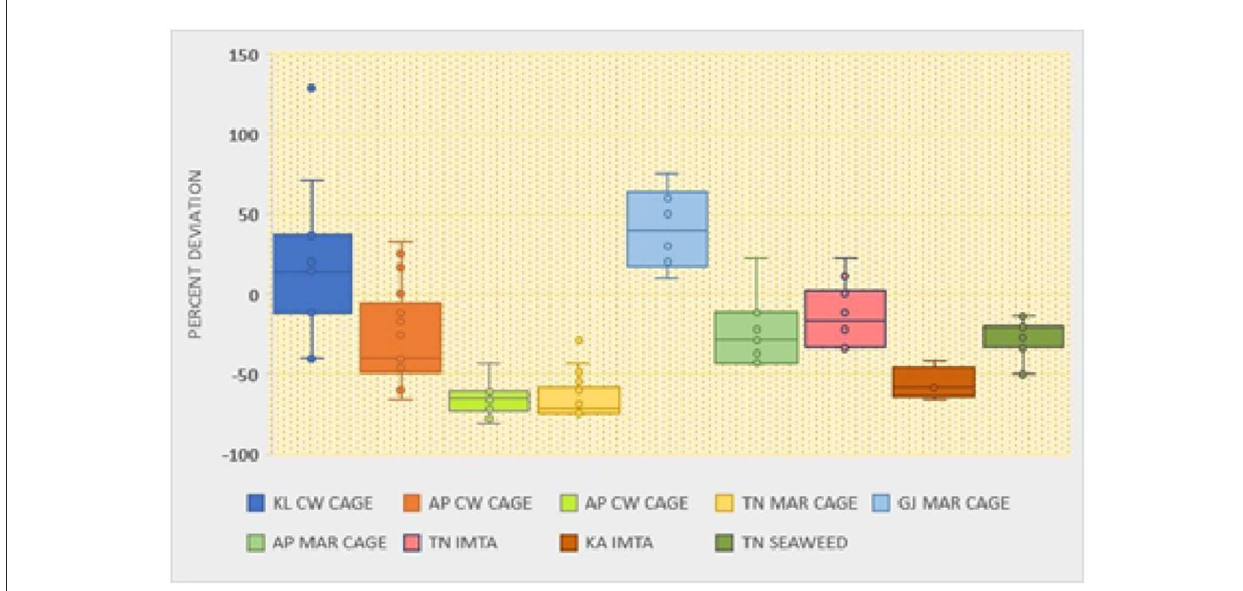
FIGURE5 Box plot depicting percent deviation concerning recommended stocking density in sample farms, India. KL CW CAGE: Coastal water cage, Kerala; KA CW CAGE: Coastal water cage, Karnataka; AP CW CAGE: Coastal water cage, Andhra Pradesh; TN MAR CAGE: Marine cage, Tamil Nadu; GJ MAR CAGE: Marine cage, Gujarat; AP MAR CAGE: Marine cage, Andhra Pradesh; KA IMTA: IMTA, Karnataka; TN IMTA: IMTA, Tamil Nadu; TN SEAWEED: Seaweed, Tamil